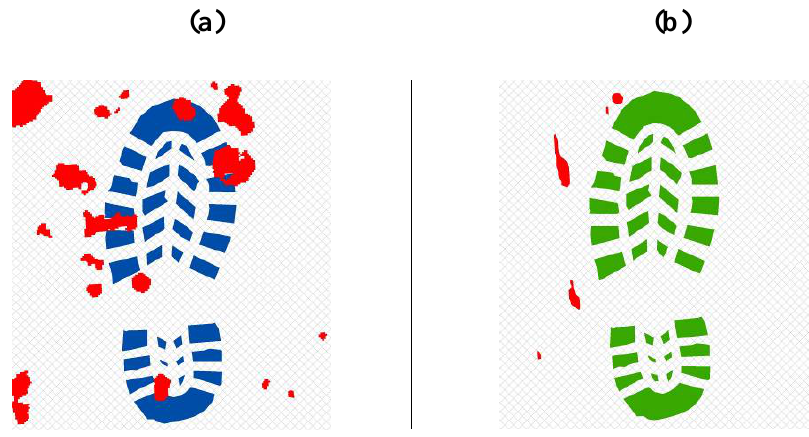
Figure 17. Software workflow, step 4; (a) Step intersecting blood pattern; (b) step non intersecting blood pattern.